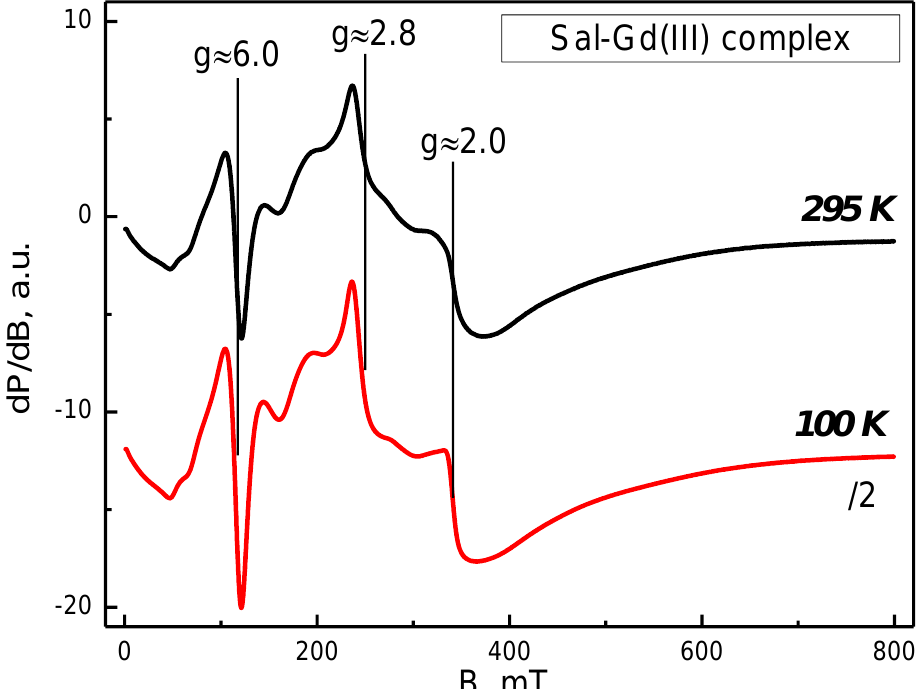
Figure 1. EPR spectra of Sal-Gd(III) complex (solid-state) at 295 and 100 K. The U-spectra signals (g ≈ 6.0, g ≈ 2.8, and g ≈ 2.0) are designated. (g ≈ 6.0, g ≈ 2.8, and g ≈ 2.0) are